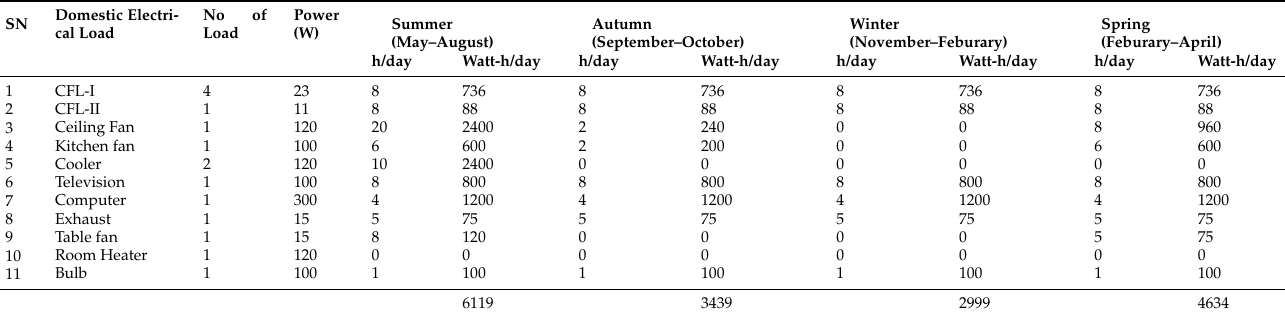
Figure 1. Seasonal variation of load demand of the area. Table 1. Estimated load demand for the village area under